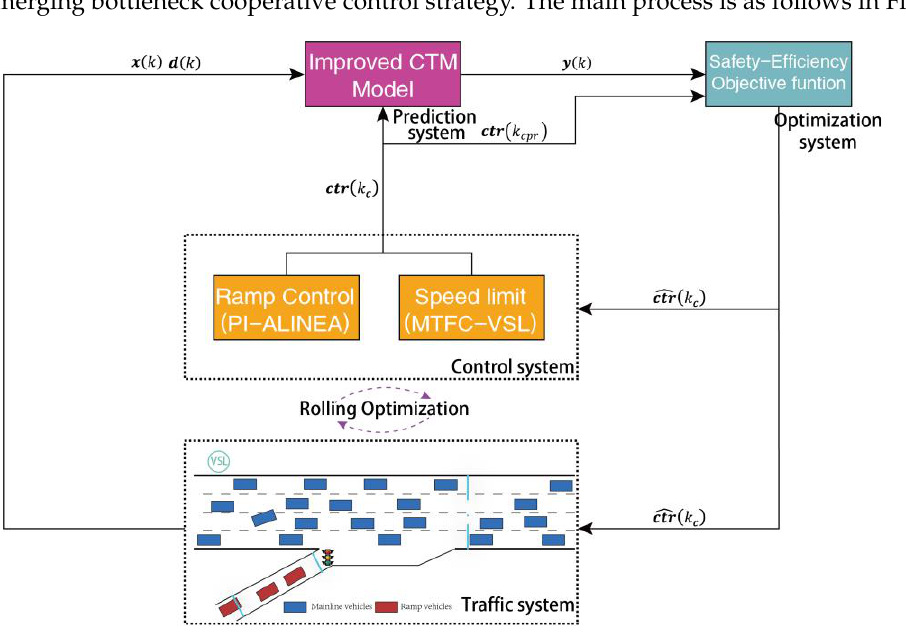
Figure 6. Merging bottleneck collaborative control strategy structure.